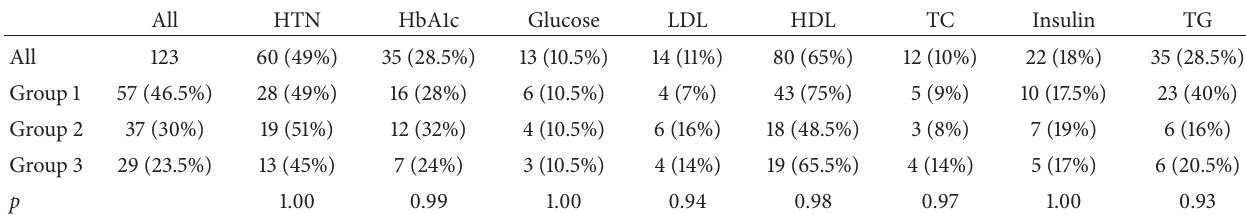
Table 2: Count of children with various abnormal results among the different